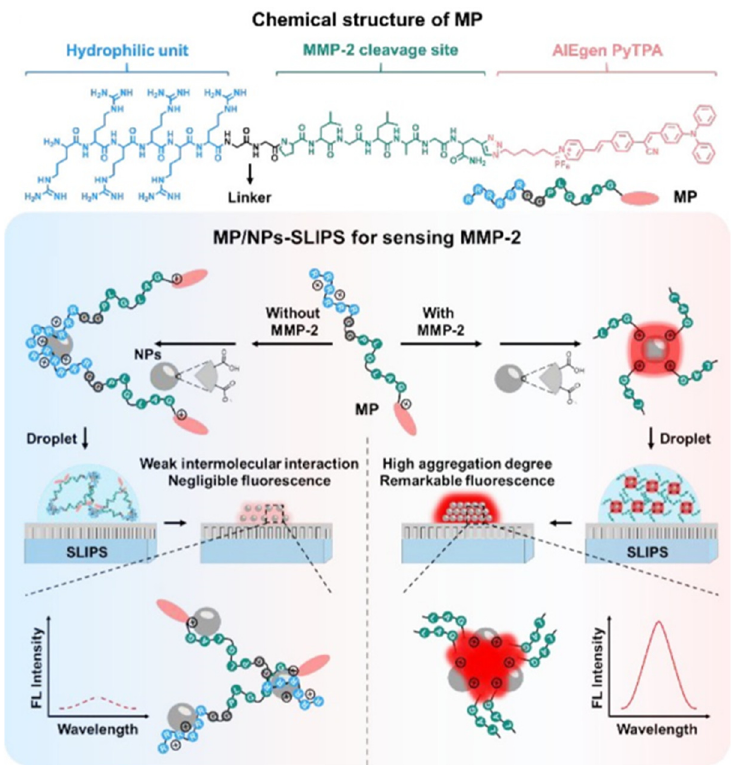
Figure 2. Design of modular peptide-conjugated AIEgen MP and development of the MP/NPs–SLIPS sensing system for sensitively detecting tumor marker MMP-2. Reprinted with permission from ref. [45]. Copyright 2021, American Chemical Society.